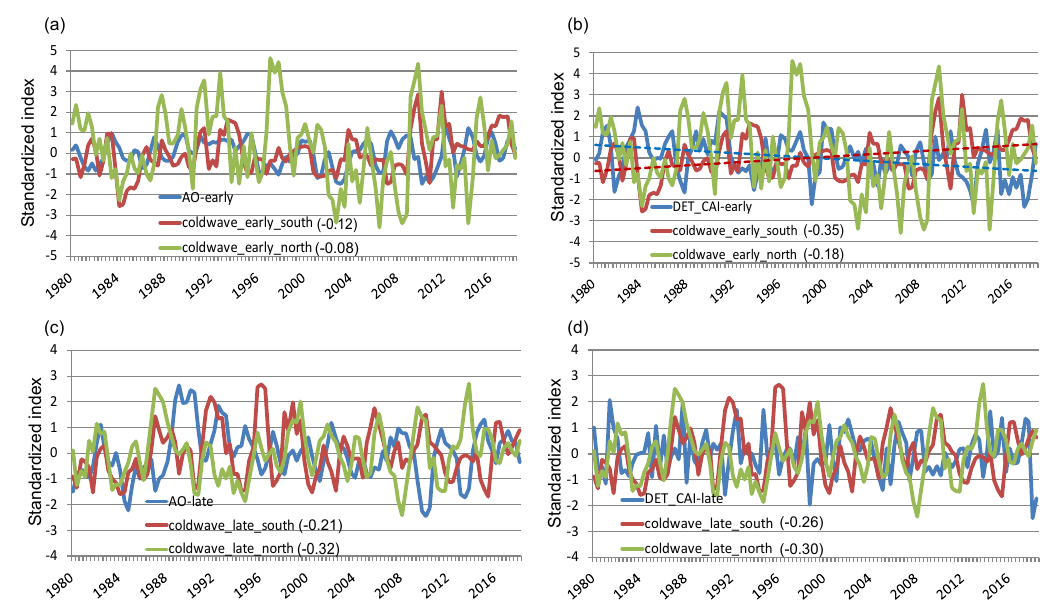
Figure 4. Standardized time series in early winter for all months during 1979–2018 of ( a ) the monthly Arctic Oscillation (AO) index and total cold wave record number and ( b ) the DET_CAI index and ( c , d ) that for late winter, respectively: The numbers in the legend indicate the correlation efficient with AO or DET_CAI. The dashed lines are the trend of DET_CAI and early winter cold wave